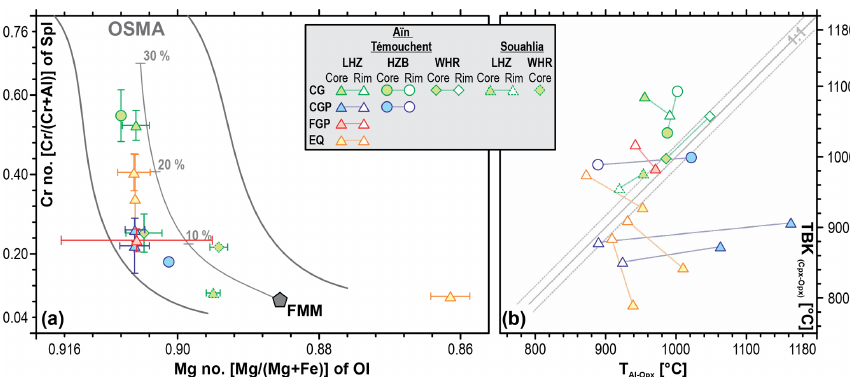
Figure 7. (a) Plot of spinel Cr no. [Cr /( Cr + Al ) ] versus olivine Mg no. [Mg /( Mg + Fe ) ] expressed as atom per formula units. The olivine– spinel mantle array (OSMA) and degrees of partial melting are from Arai (1994). FMM (grey pentagon) is the fertile MORB mantle (after Pearce et al., 2000). Ol: olivine; Spl: spinel. (b) Estimated temperatures of Oran mantle peridotites based on the Cr–Al–orthopyroxene ( T Al − Opx ) geothermometer of Witt-Eickschen and Seck (1991), and the two-pyroxene solvus ( T Cpx − Opx ) geothermometer of Brey and Köhler (1990). Data are presented in Table 1; see abbreviations in Fig. 2.